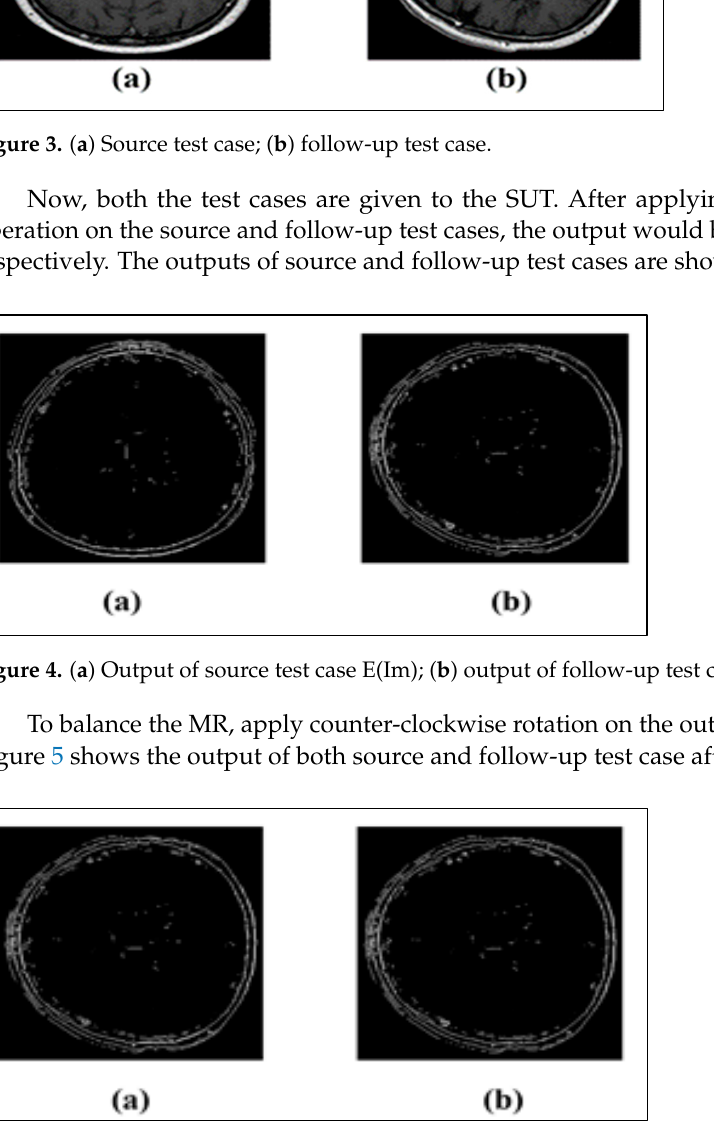
Figure 5. ( a ) C(E(Im); ( b )